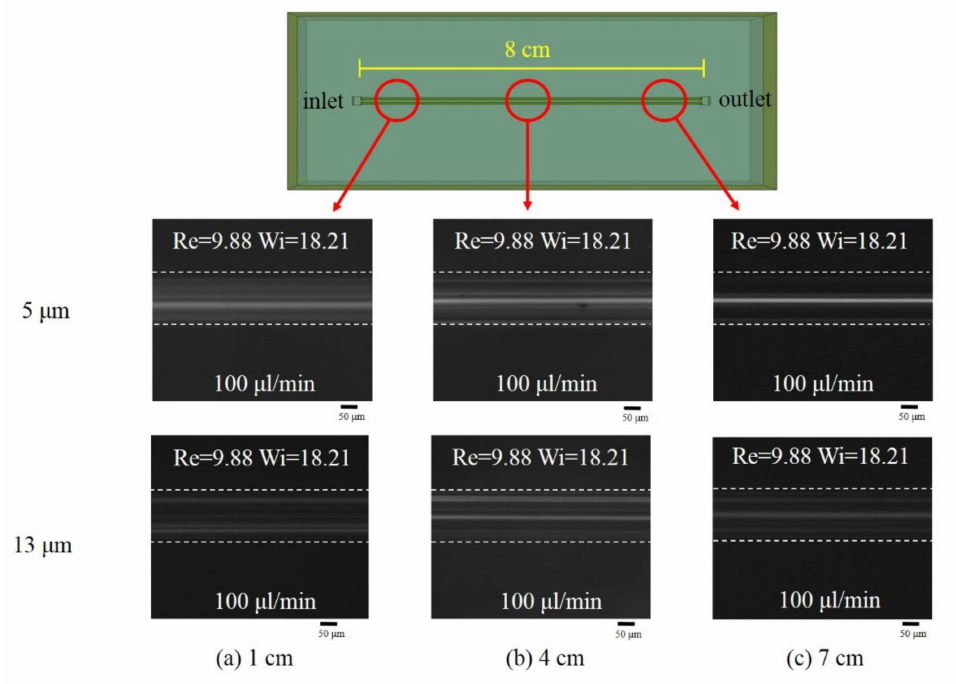
Figure 4. Optical images (top view) at a 100 µ L/min flow rate in viscoelastic fluid at different distances from the inlet for different particle sizes. ( a ) 1 cm, ( b ) 4 cm, ( c ) 7 cm from the inlet of the Type 3